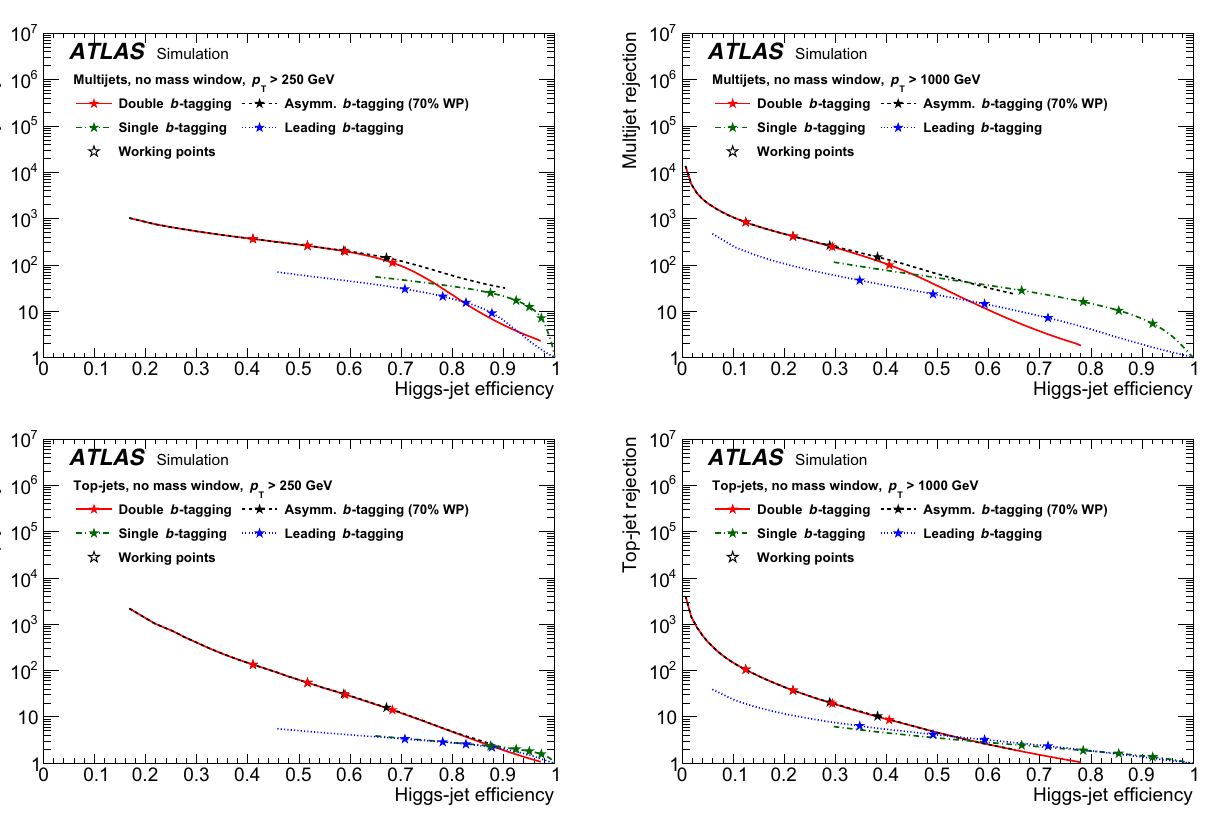
85% b -tagging WPs (from left to right). The curves for the double- b - tagging and asymmetric- b -tagging working points coincide over a large range of Higgs-jet